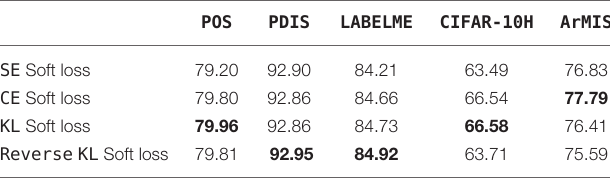
TABLE 1 | The effect of different loss functions for soft loss training on accuracy.